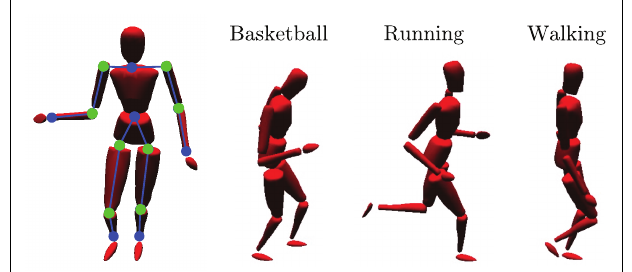
FIGURE 3 | Simulated body driven by motion capture data . The left-sided image shows the limbs (blue lines between dots) and joints (green dots) that provide relative visual and joint angular input to the model. Moreover, three snapshots of the utilized motion tracking trials are shown: basketball dribbling, running, and